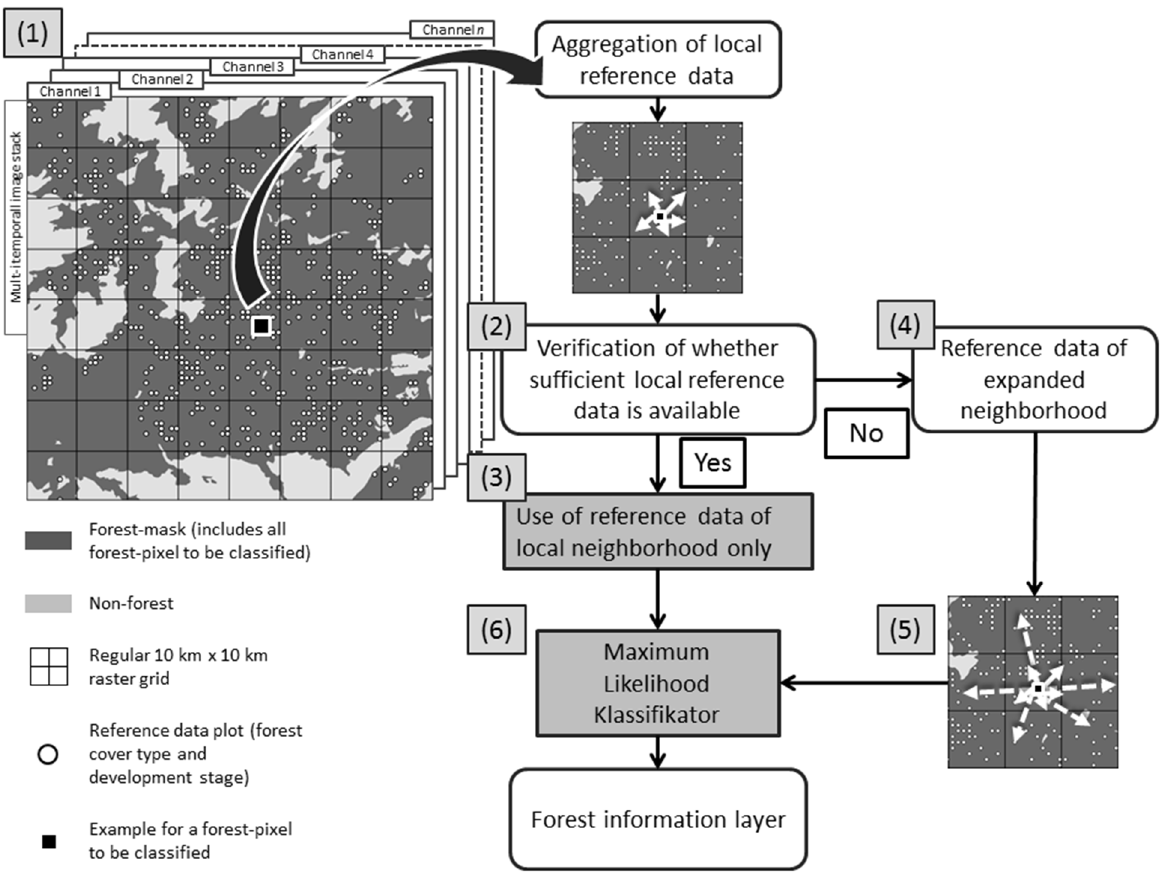
Figure 4. Flowchart of the spatially adaptive classification